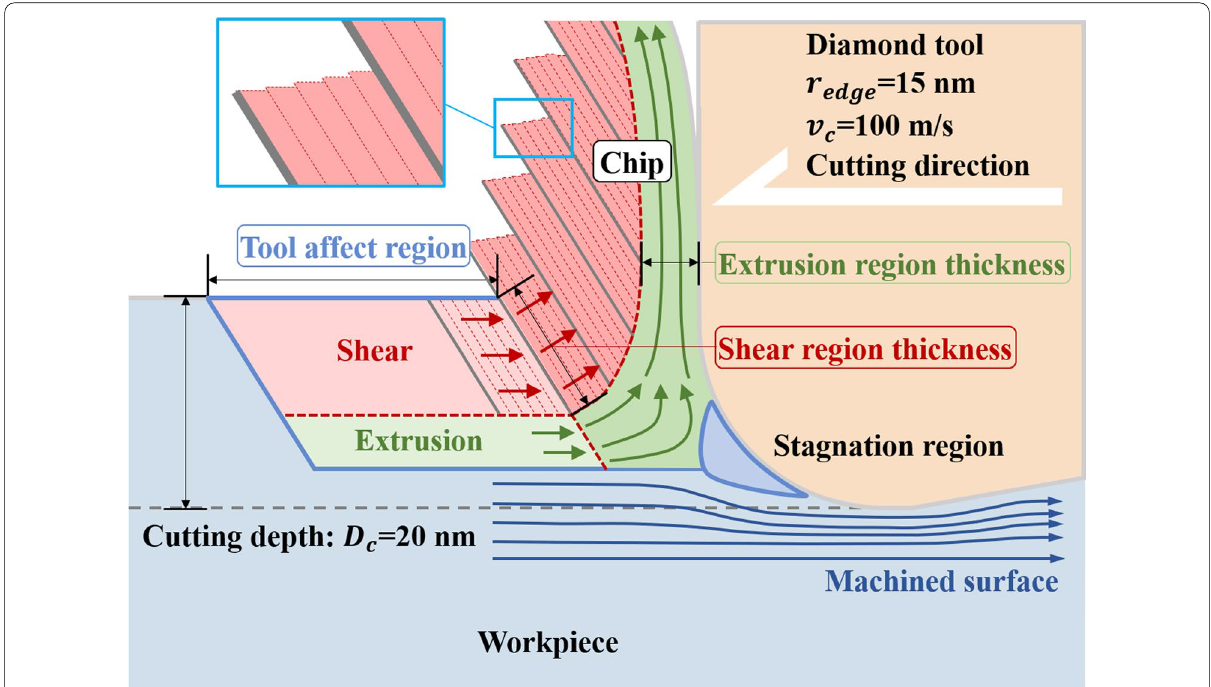
Fig. 14 Schematic diagram of chip formation by shearing and